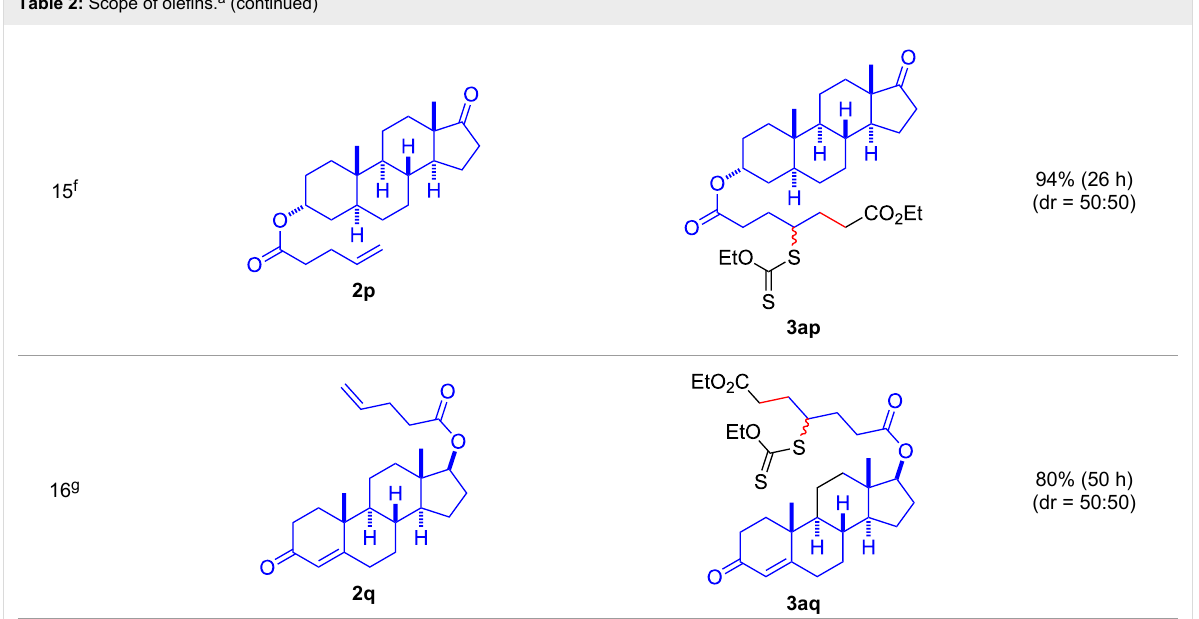
Table 2: Scope of olefins. a (continued)